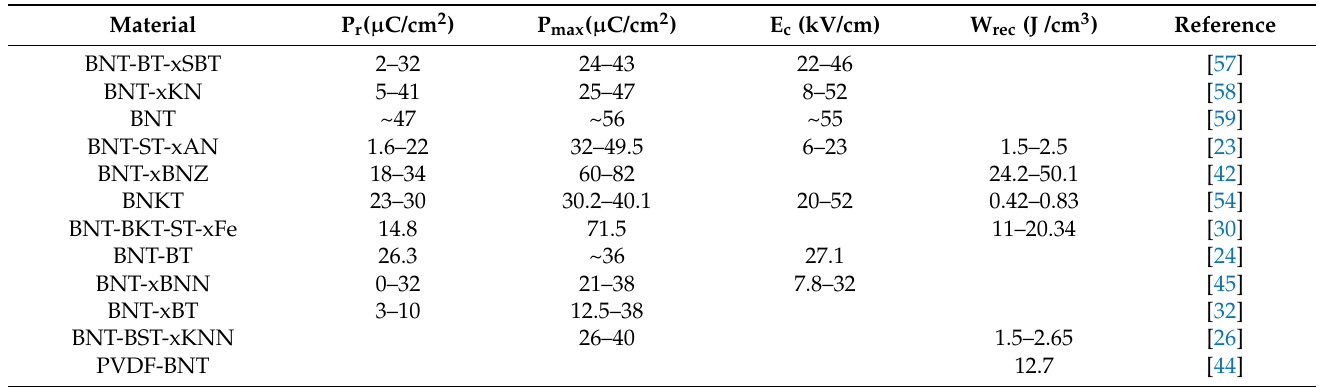
Table 2. Summary of ferroelectric and energy storage properties of BNT